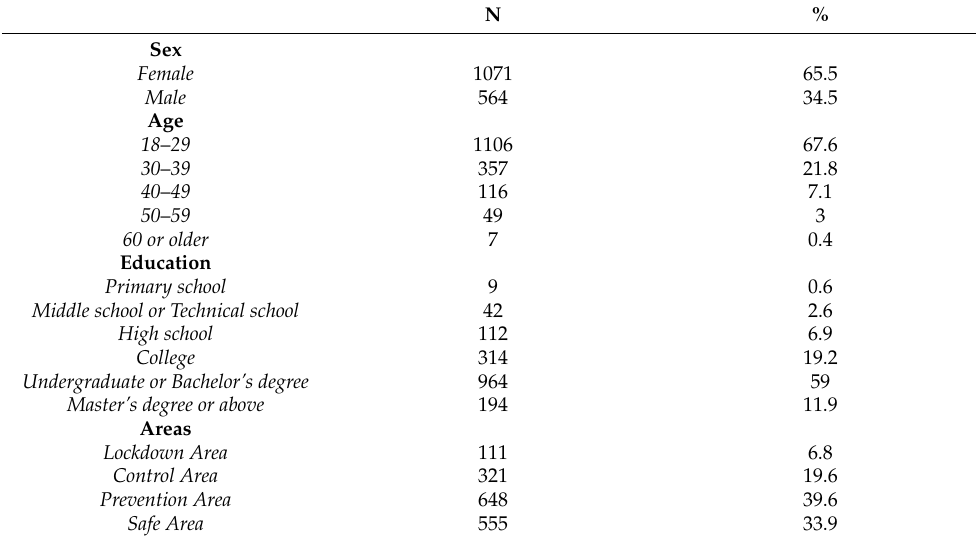
Table 1. Demographic characteristics (N =